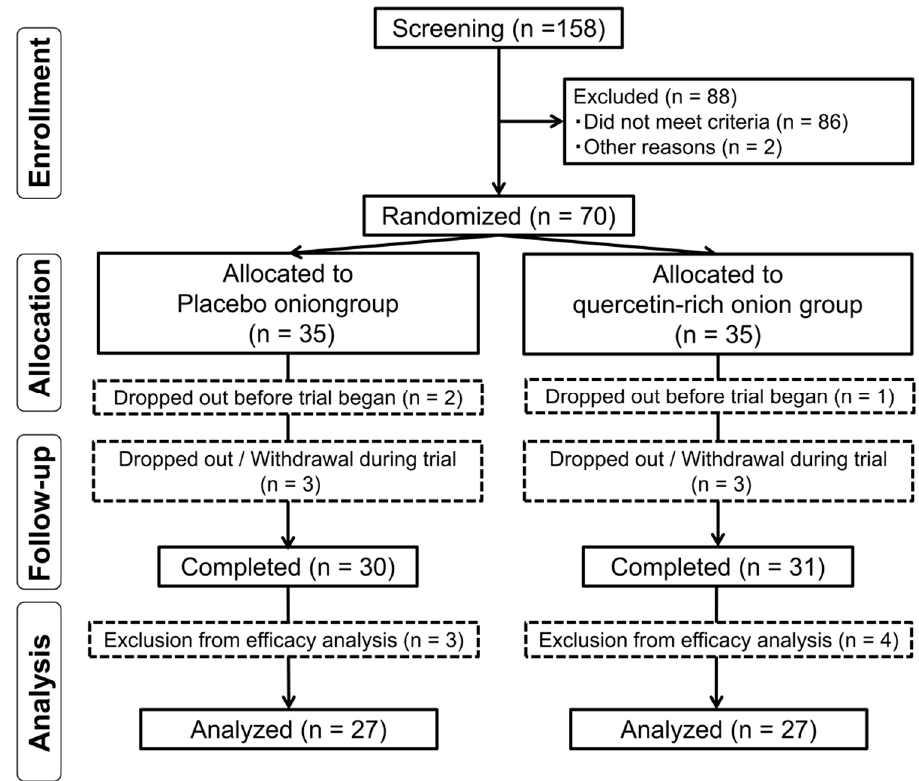
Figure 1. Flow chart for involvement of subjects during the trial.